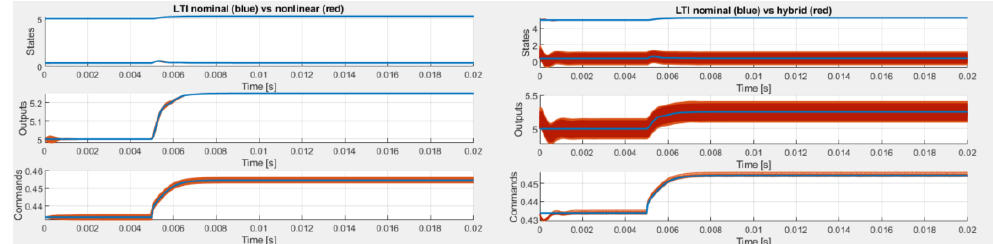
Figure 13. Buck averaged state-space and hybrid model Monte Carlo closed loop simulations with a closed loop bandwidth ω B > 1200 [rad/s], equivalent to a rise time of ≈ 0.83 [ms], negligible steady-state error, and no